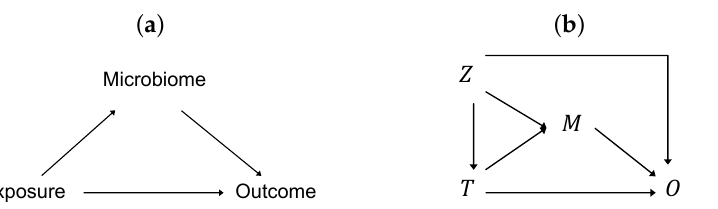
Figure 1. ( a ) Some effect of an exposure on an outcome is mediated through the microbiome. ( b ) T denotes the exposure, M the microbiome (mediator), O the outcome, and Z the confounding covariates. There are a number of special challenges in mediation analysis of microbiome